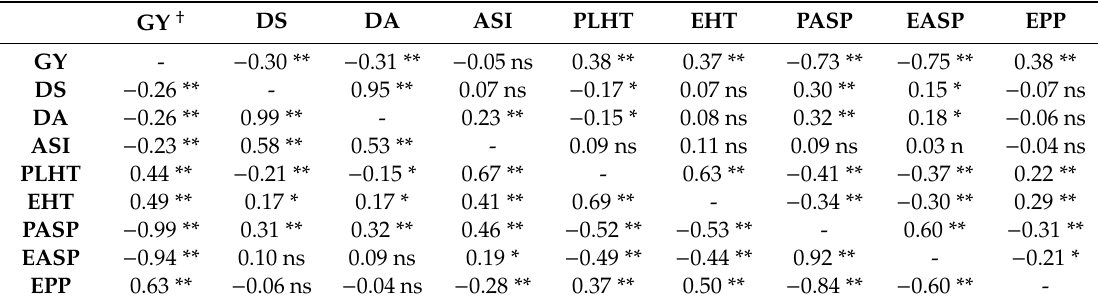
Table 7. Phenotypic (above diagonal) and genotypic (below diagonal) correlation coe ffi cient between grain yield and secondary traits † under optimal conditions at Ikenne and Bagauda during 2014 cropping